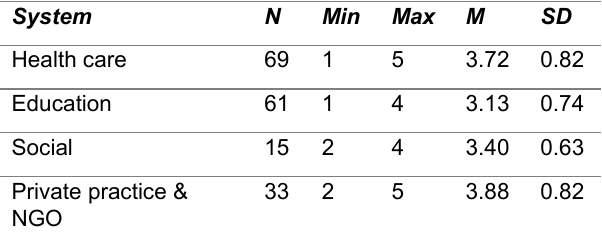
Level of Satisfaction Distributed Across Systems